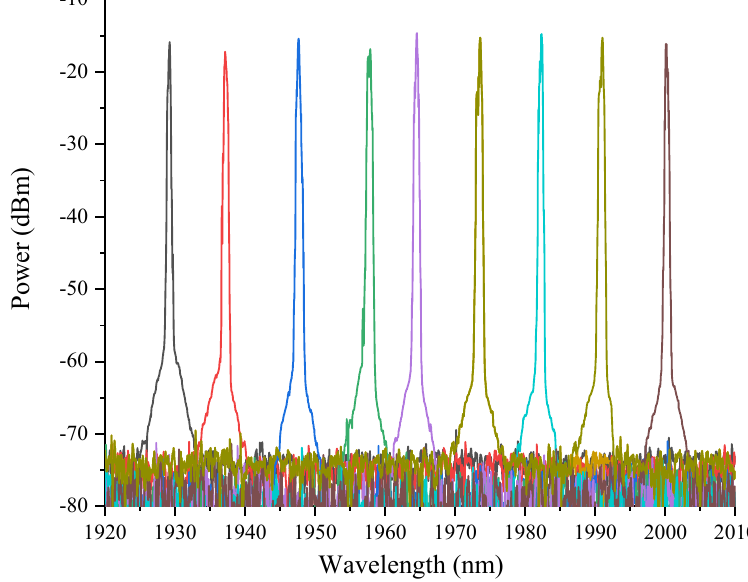
Figure 5. Typical output from thulium-doped fiber laser based on a DMD chip.